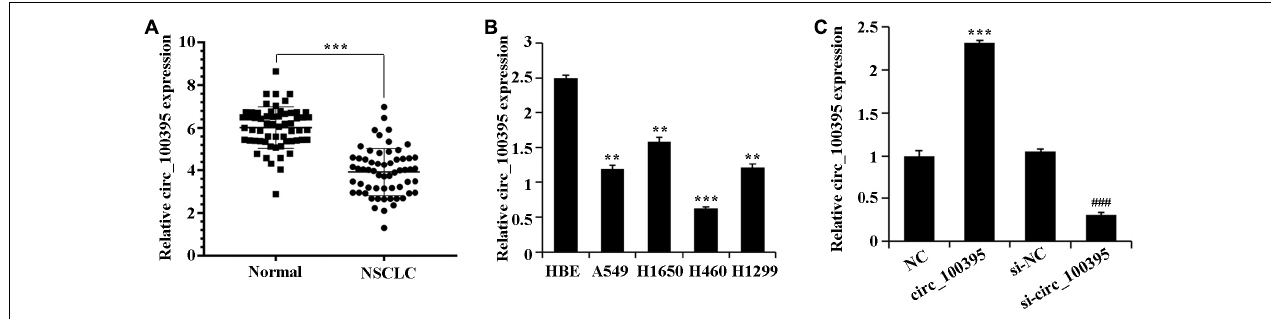
FIGURE 1 | Low circ_100395 expressed in NSCLC tissues and cells. (A) Evaluation of circ_100395 expressed in paracancerous and NSCLC tissues using qRT-PCR. *** p < 0.001 vs Normal group. (B) Evaluation of circ_100395 expressed in human bronchial epithelial cell line 16 HBE-T and NSCLC cell lines using qRT-PCR. ** p < 0.01 and *** p < 0.001 vs HBE; (C) Evaluation of circ_100395 expressed in H1650 cells of each treatment group using qRT-PCR. *** p < 0.001 vs NC group and ### p < 0.001 vs si-NC